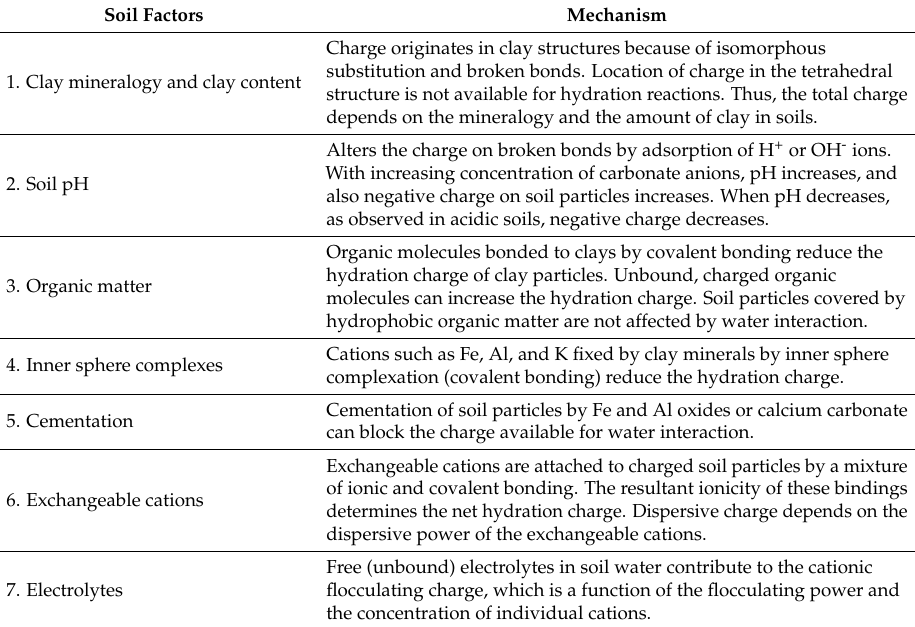
Table 2. Soil factors controlling swelling, dispersion, and